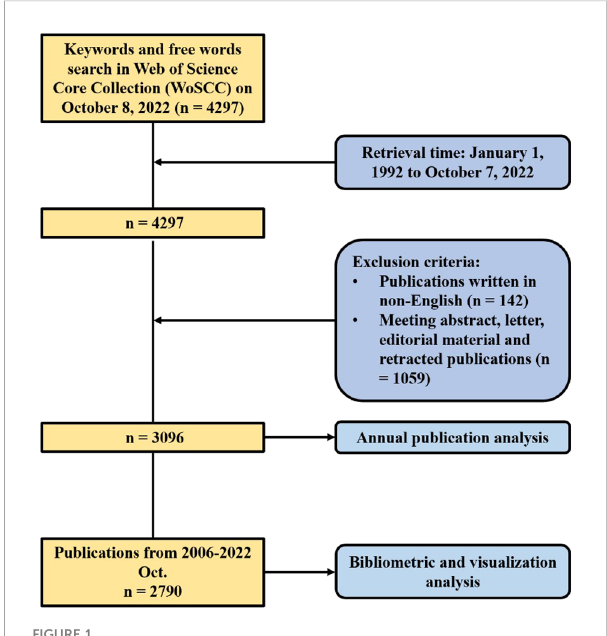
FIGURE 1 Flowchart of the process of publication